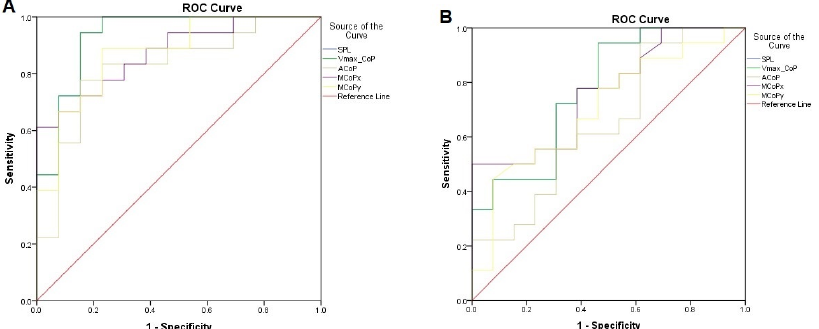
Figure 3. ROC curve and the optimal cutoff points for individual variables in supine ( A ) and prone position ( B ).